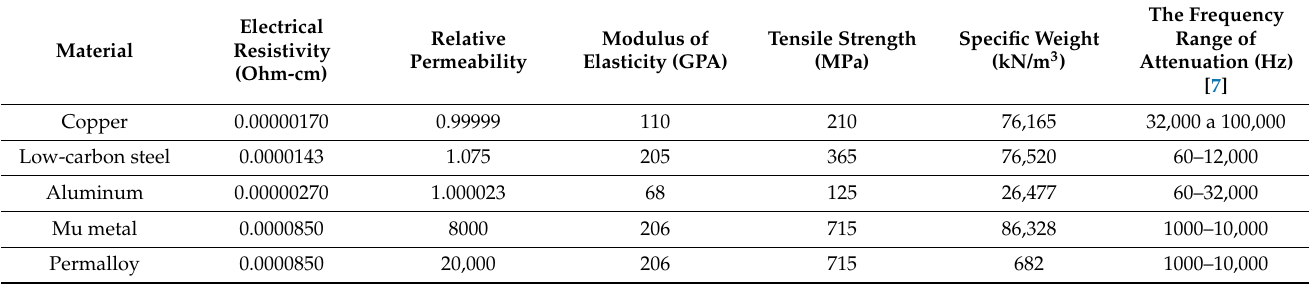
Table 1. Characteristics of materials that can be used in EMI